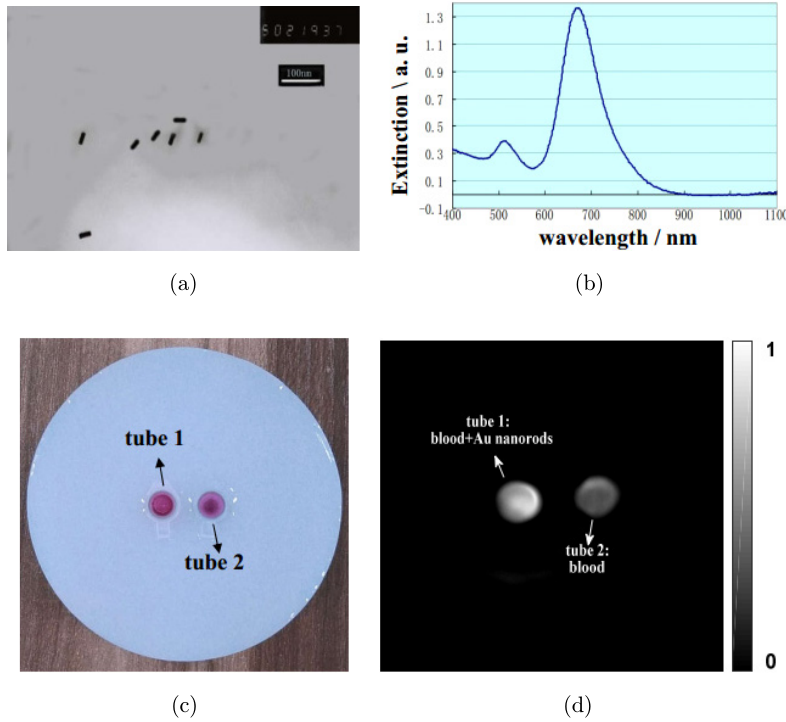
Fig. 2. (a) SEM image of the GNRs (Au nanorods) used in our study. (b) Optical absorption spectrum of these GNRs. (c) Photograph of tubes 1 and 2 embedded in a phantom. (d) Photoacoustic image for tubes 1 and